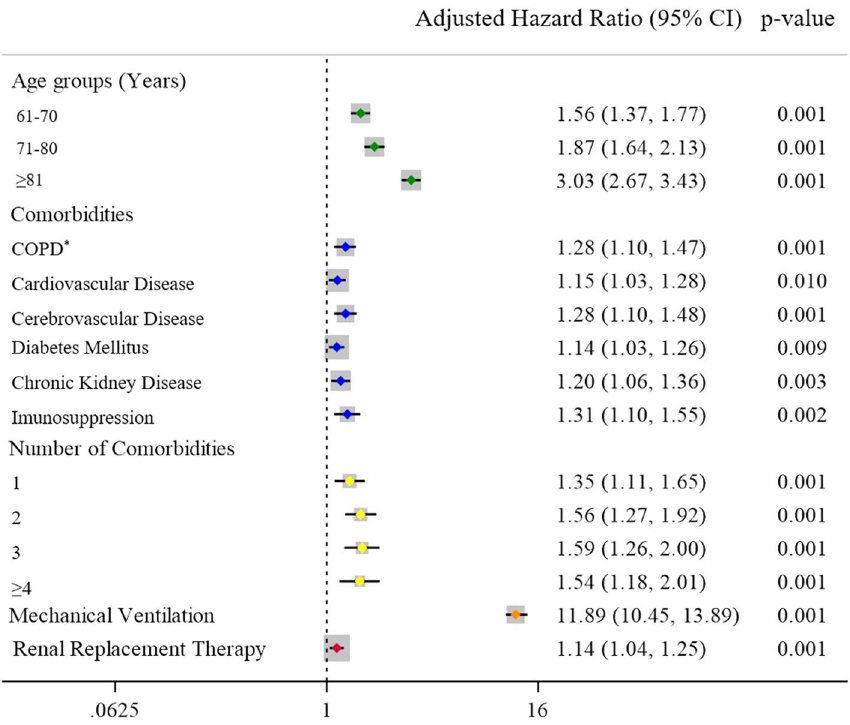
Figure 2. Variables associated with in-hospital mortality in patients hospitalized due to coronavirus 2019 disease between March 1st, 2020 and March 31st, 2021. Analysis adjusted by the Cox regression model. *Chronic obstructive pulmonary